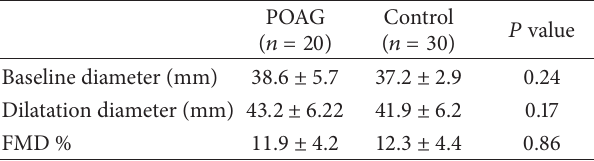
Table 2: Vascular